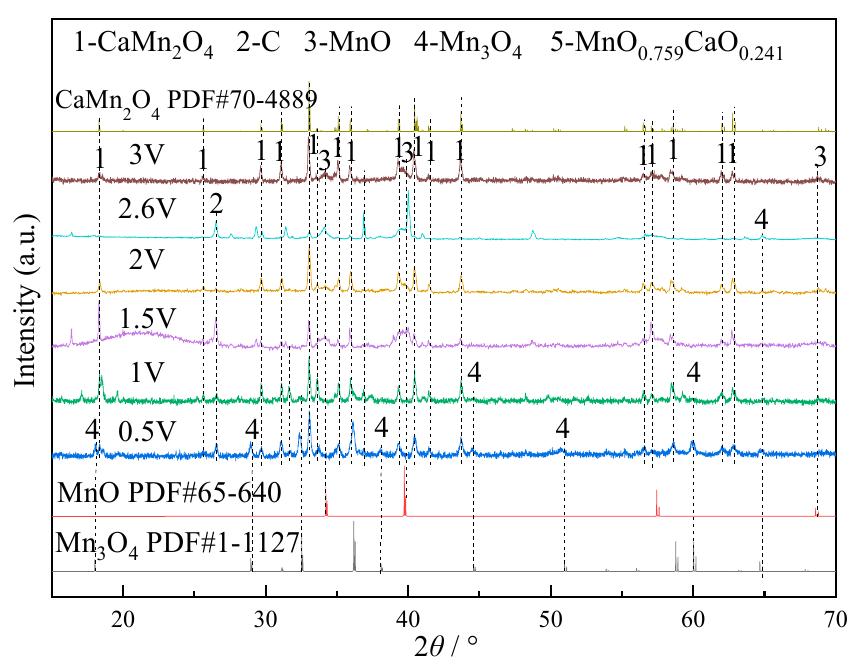
Figure 9. LiMn 2 O 4 electrolytic deoxidation products at 750 ◦ C (1 h, 0.5–3 V). As shown in Figure 9, when the electrolysis voltage is 0.5 V~1 V, CaMn 2 O 4 and Mn 3 O 4 are formed. When the electrolysis voltage increases to 1.5 V~3 V, the characteristic peak of Mn 3 O 4 in the product disappears, and the trivalent manganese is transformed into divalent manganese, forming (MnO) x (CaO) (1 − x ) and MnO. The reason for this is in the process of electrolytic reduction of high-valent manganese to elemental manganese, it needs to rely on energy to promote the process of obtaining electrons. The driving force of the process is voltage. The magnitude of the applied voltage determines whether the electrochemical reaction can proceed and the extent of the reaction. The electrochemical reaction that can be carried out requires energy to break its thermodynamic conditions, that is, the equilibrium potential, while the occurrence of the kinetic process requires a certain over-potential. When the over-potential is greater, the reaction speed is greater. According to the analysis of electrolysis products at different electrolysis voltages in a short time, when the voltage is greater, the driving force of the reaction is greater, the reaction speed is faster, and the degree of reaction progress is greater. Therefore, the reduction process of high valent manganese is: LiMn 2 O 4 (III, IV) is reduced and chemically reacts with Ca 2+ in the molten salt to form CaMn 2 O 4 ; Subsequently, Mn (III) in CaMn 2 O 4 undergoes a reduction reaction to produce MnO, while CaO is gradually separated, and the x in (MnO) x (CaO) (1 − x ) that appears during the reaction gradually becomes